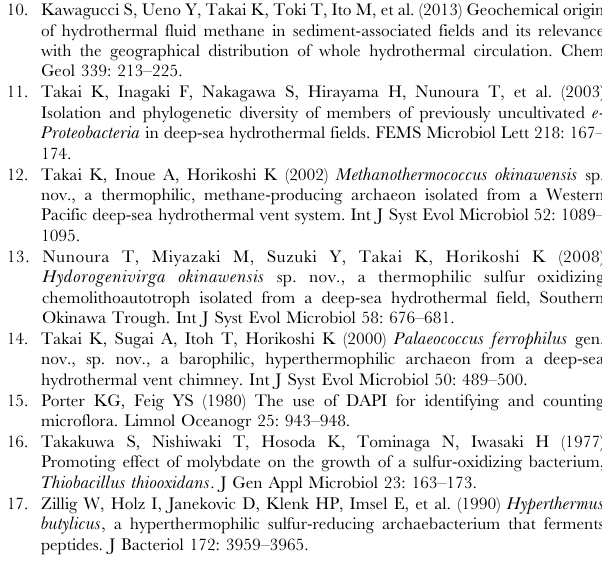
Figure S1 A scanning micrograph of broken polysac- charide-like substance layer on elemental sulfur. Bar,